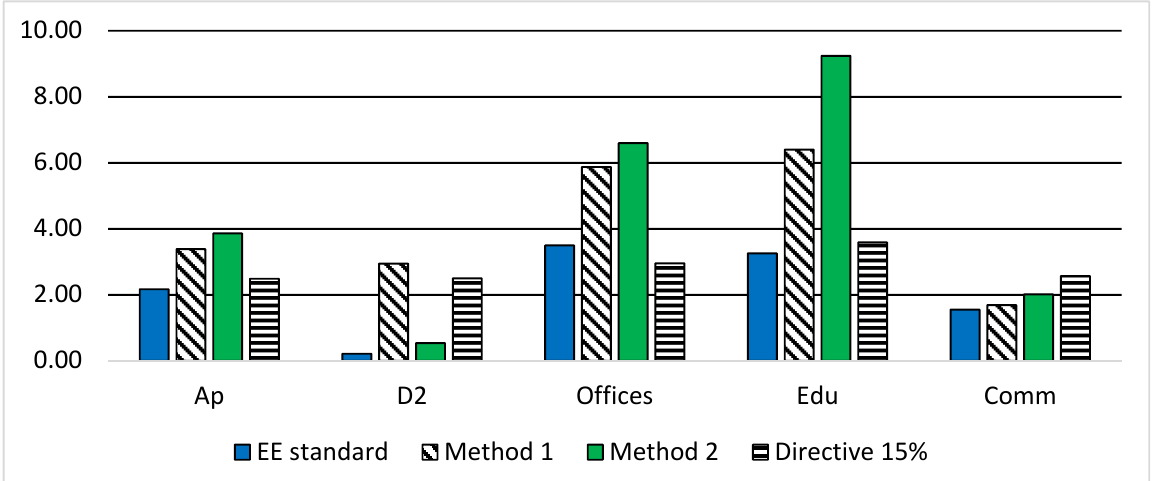
Figure 4 . Renovation rates (%) for selected building categories. Figure 4. Renovation rates (%) for selected building categories.